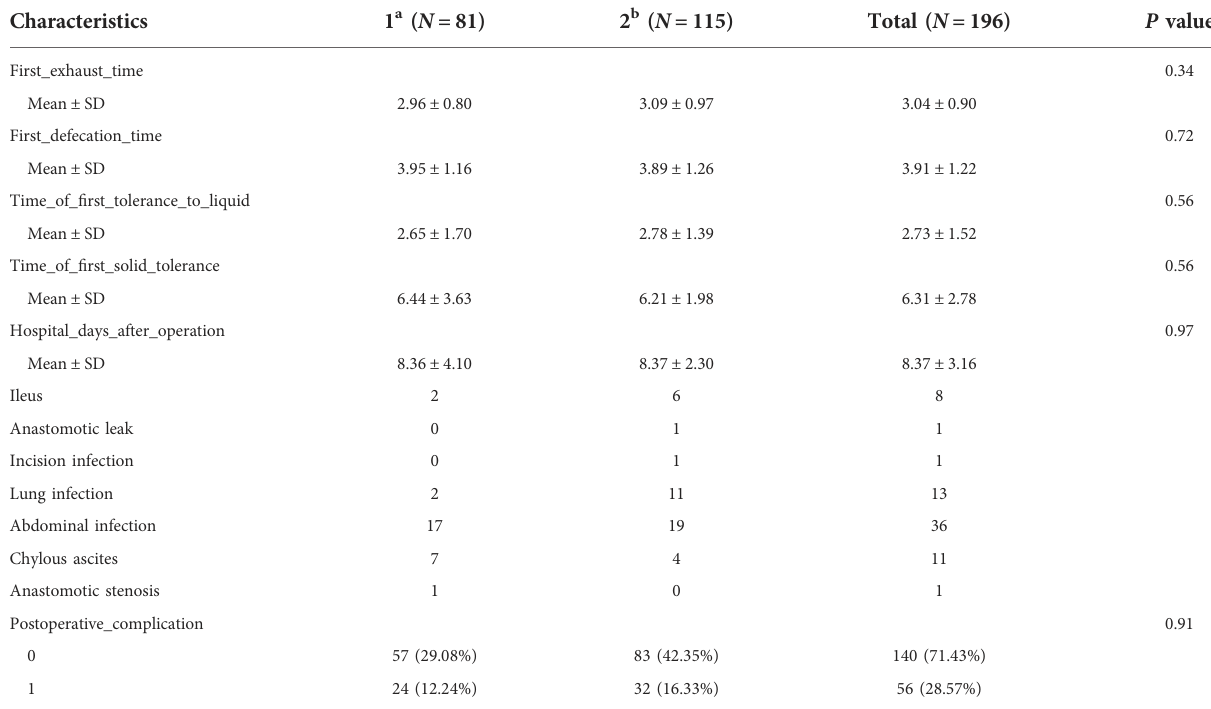
TABLE 2 Comparison of postoperative indexes between two groups of patients ( n =196, x ± s ).